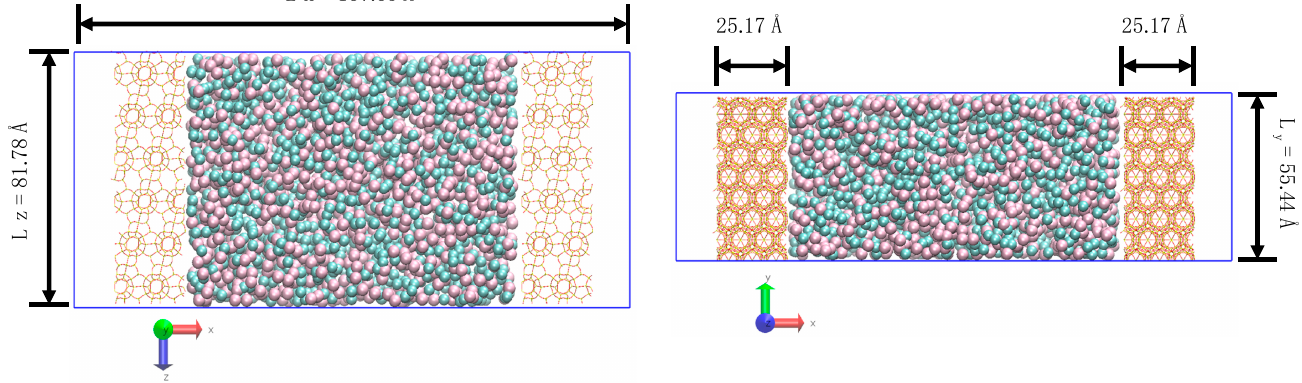
Figure 1. Overall view of the simulation box including top view ( left ) and front view ( right ) at the beginning of the simulation. The membrane is 2.517 nm thick.